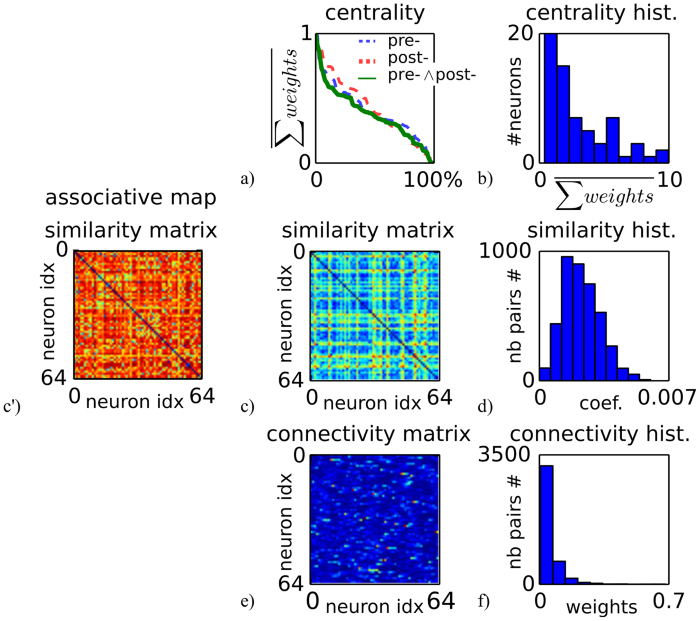
Measures and indices to characterize the functional organization of the recurrent neural network based on complex networks and graph theory.(a,b) The centrality index describes the relative effectiveness of neurons within the network in terms of the number of pre-synaptic and post-synaptic connections. The power-law curve is characteristic of small-world-networks, where the most connected neurons represent the network’s “hubs.” (c-c’-d) The similarity index measures the similarity among the neurons by comparing their weights; asso map in (c’) and rec map in (c). An important mass of neurons constitutes the network, which guaranties some redundancy, but the less similar ones potentially correspond to the most critical ones. (e,f) The connectivity matrix permits identification of the unidirectional connections or causal links between the pairs of neurons. This method is complementary to the centrality measure. The stronger the value of this index, the stronger the influence of the neuron on its associated neurons. Again, the logarithmic curve of the histogram is characteristic of complex and hierarchical networks.